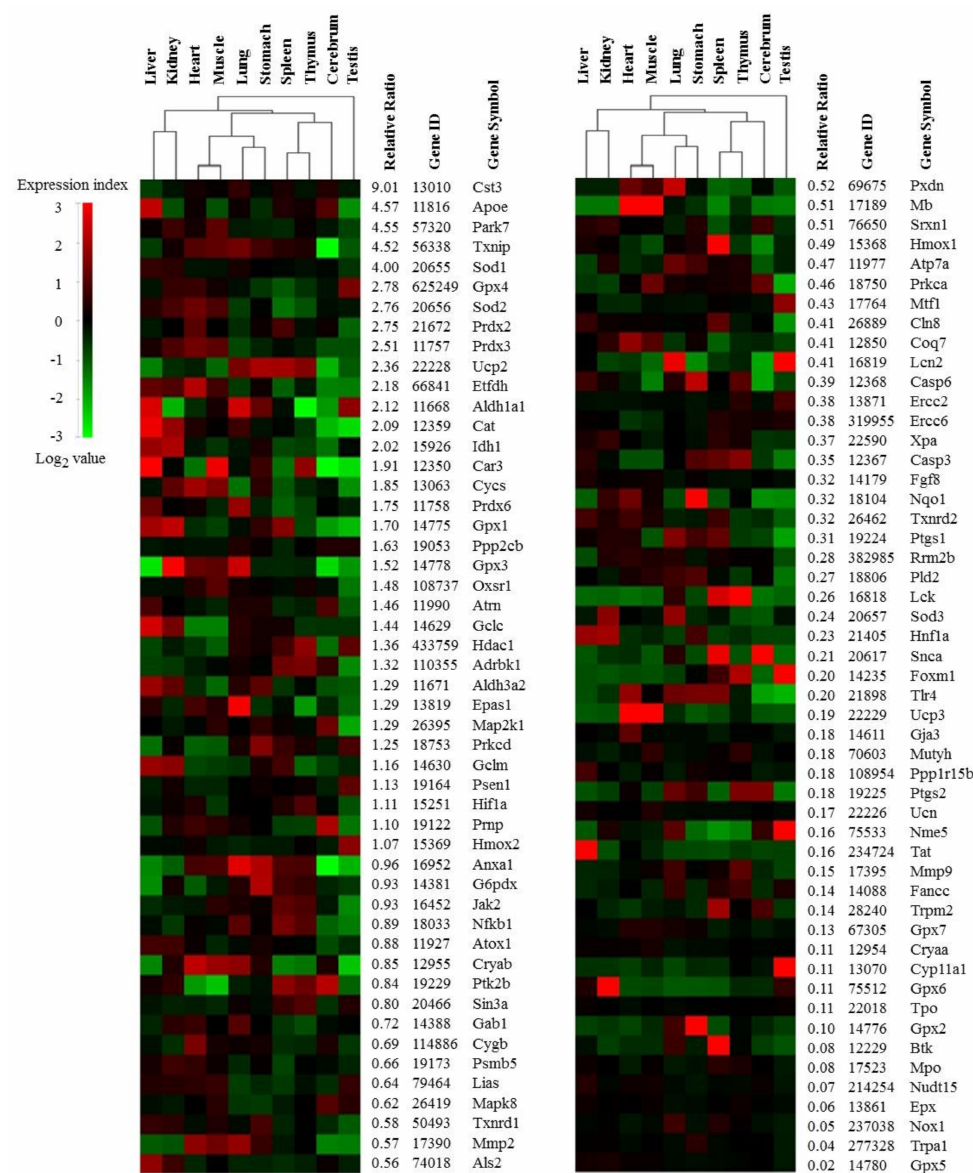
Figure 1. Tissue-specific expression pattern of oxidative stress-related 101 genes. Tissues were ordered according to hierarchical clustering ( x -axis), while genes were ordered by the relative ratio. The ratio (log base 2) of the signal intensity of each gene within one tissue was divided by the mean signal intensity of all 10 tissues. The red and green colors represent >2-fold up and downregulated genes,